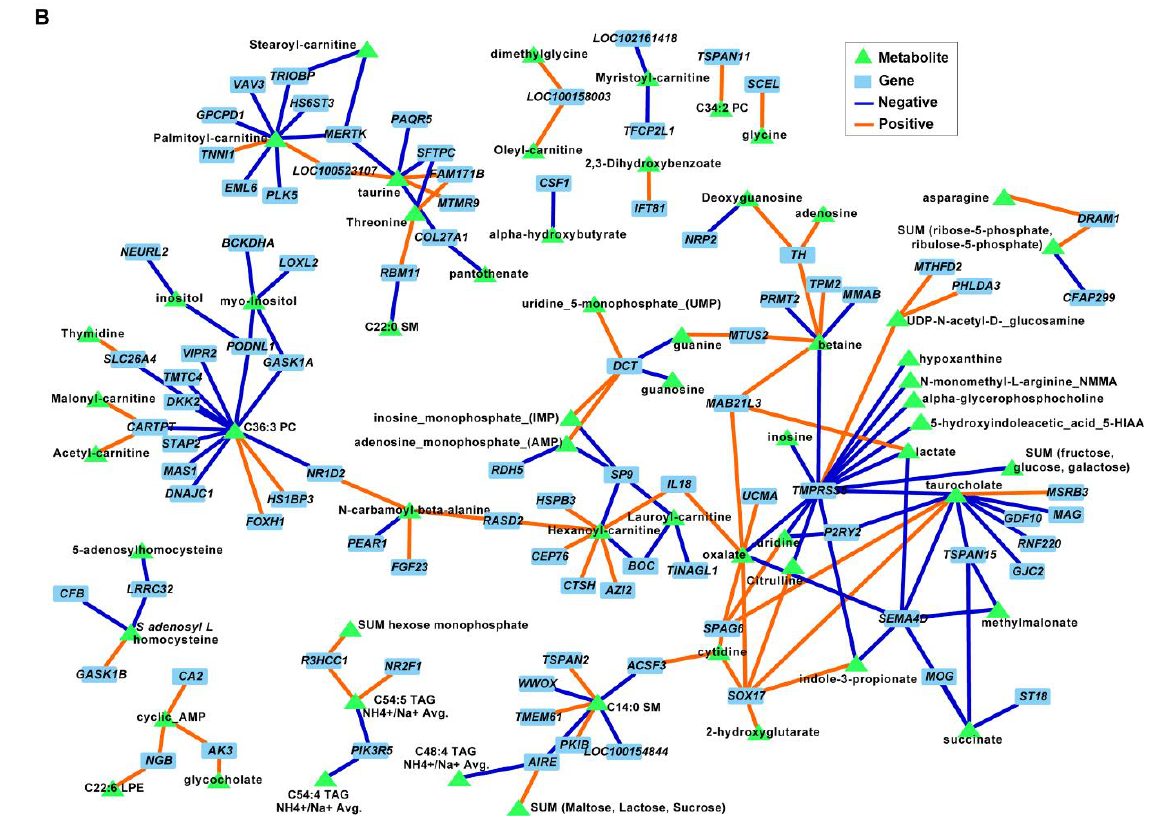
Figure 8. Associations between differentially expressed genes (DEGs) and bile acids ( A ) and metab- olites ( B ) in the frontal cortexes of juvenile Iberian pigs fed LAR ( n = 5 pens), OLI ( n = 5 pens), and COC ( n = 5 pens) diets on day 70 of the study. Network displays robust approximations of Pearson’s correlations using sparse partial least square (sPLS) with LASSO penalization. Orange and blue edges represent positive and negative correlations, respectively.